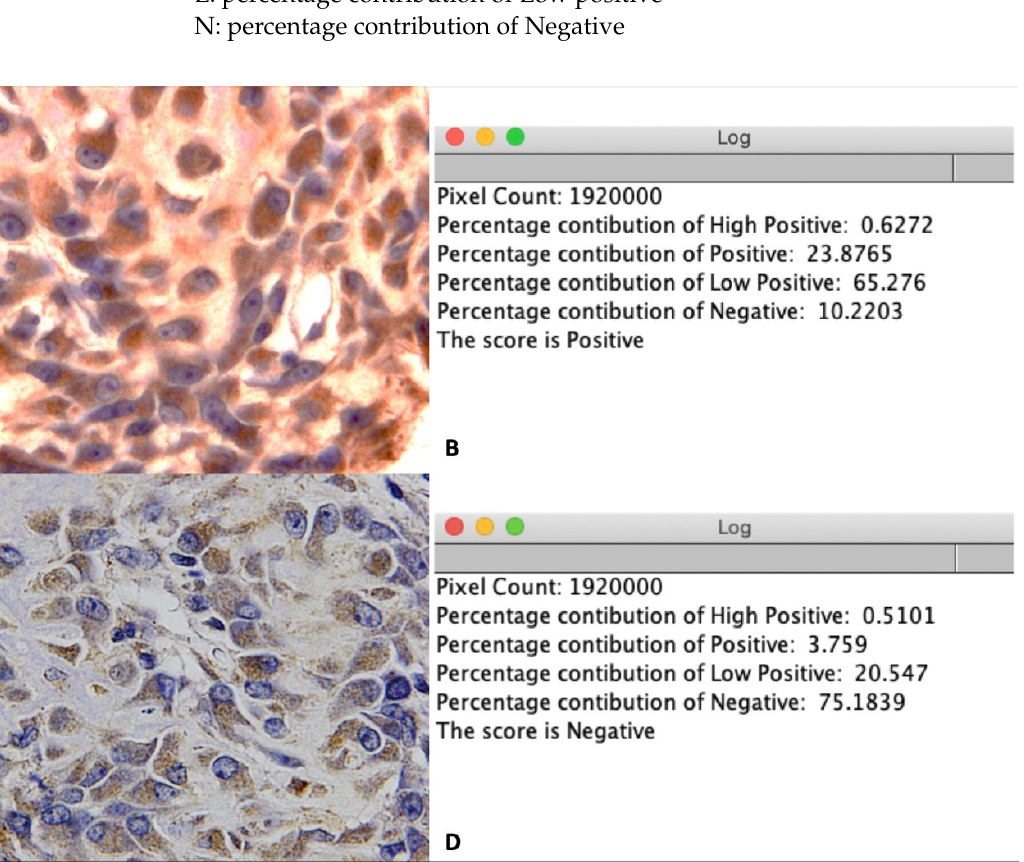
Figure 5. IHC OD score for LepR staining. ( A ) Illustration of a positive image at 100× magnification. ( B ) Positive score for image A after using the IHC profiler plugin in Fiji software. ( C ) Illustration of negative image at 100× magnification. ( D ) Negative score for image C after using the IHC profiler plugin in Fiji software.